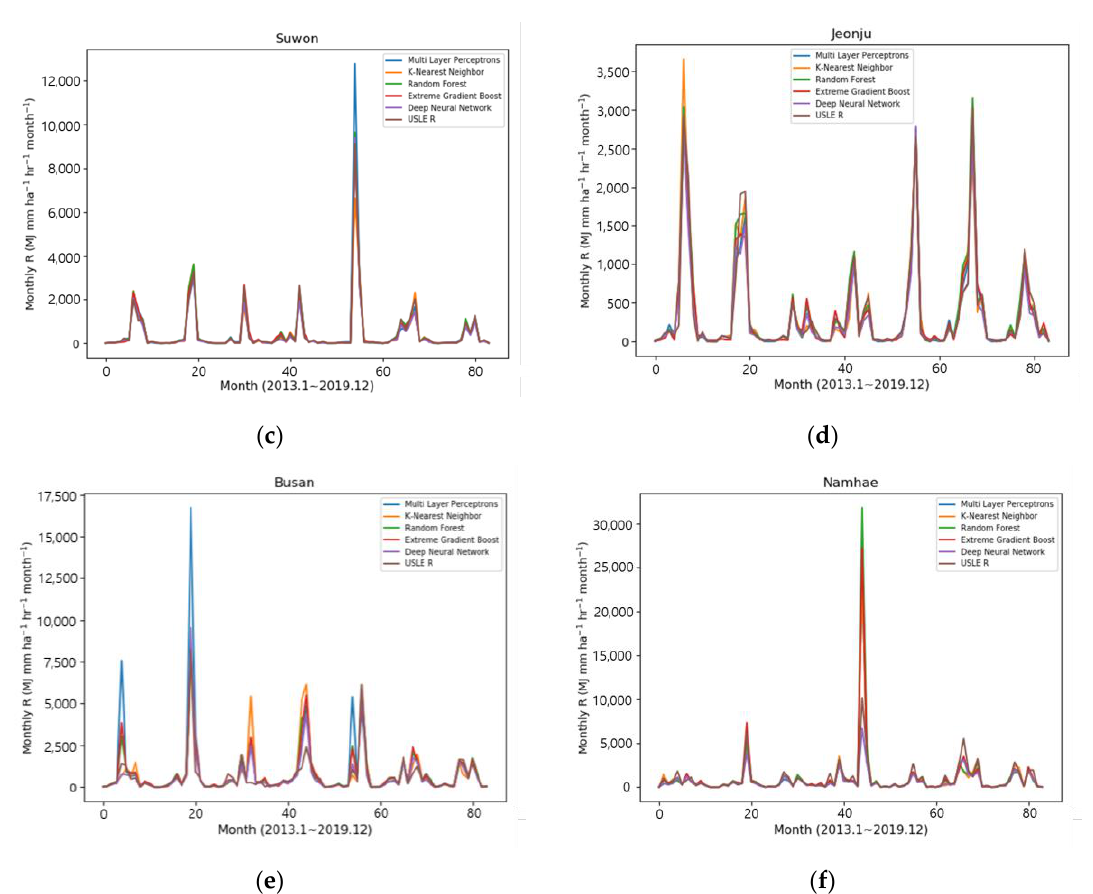
Figure 6. The comparisons of forecasting results of R-factor using machine learning in ( a ) Chuncheon, ( b ) Gangneung, ( c ) Suwon, ( d ) Jeonju, ( e ) Busan, and ( f ) Namhae.